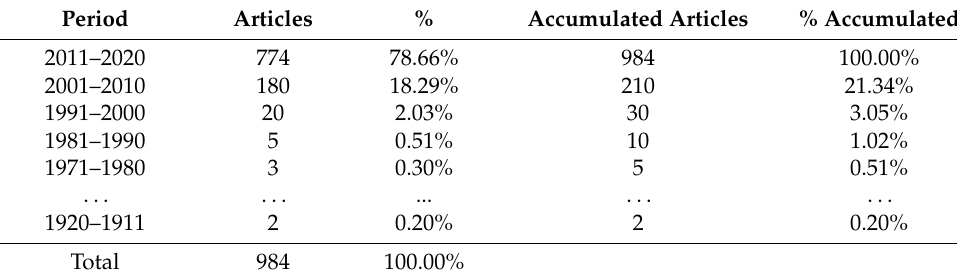
Table 1. Number of articles per decade